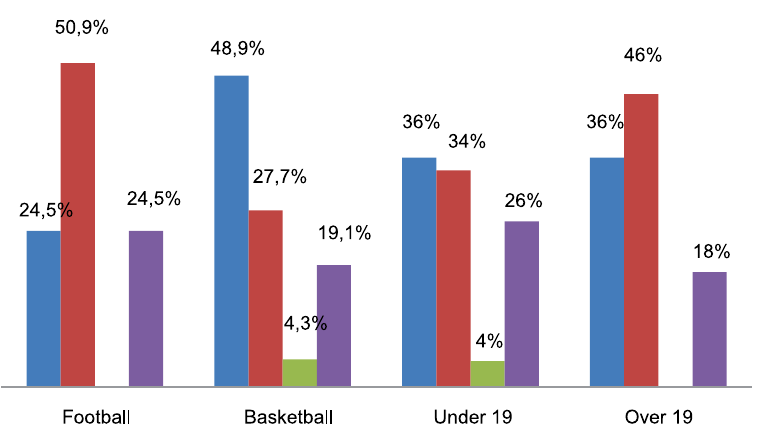
FIGURE 5. Type of meal most frequently used after the training per type of sports and age TablE 2. Type of meal most frequently used after the training per type of sports and type of